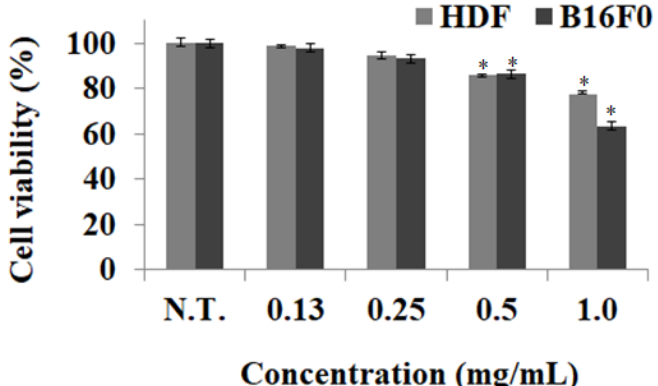
Figure 3. Inhibitory effects BCS on cell viability of HDF and B16F0. BCS: bioconverted chestnut inner shell extracts. The cell growth of the control group with the nontreated group (N.T.) at 24 h was represented as 100%. Results represent mean ± standard deviation ( n = 3). The statistical analysis of the data was carried out by use of a t -test. Values are statistically significant at * p < 0.05 vs. respective control group.